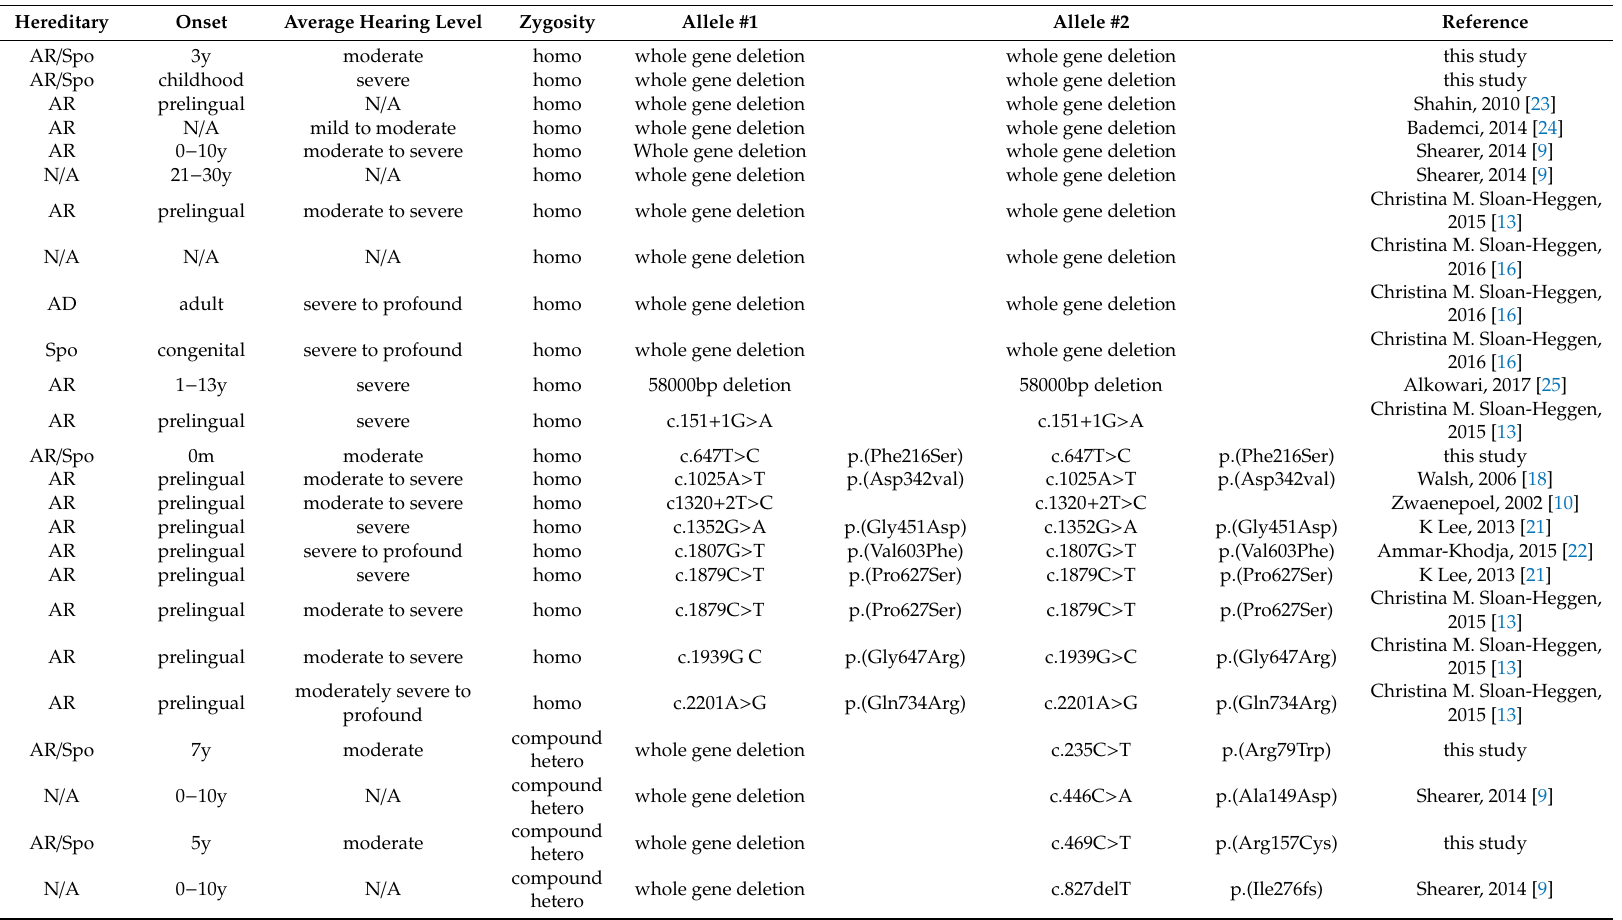
Table 4. Summary of clinical features associated with OTOA variants from this and previous